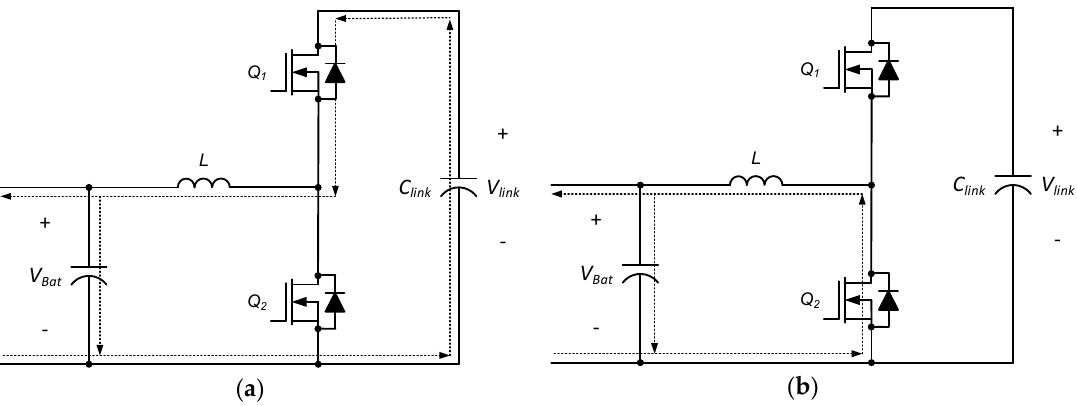
Figure 6. Capacitor discharge mode ( a ) Q 1 : turn on, Q 2 : turn off, ( b ) Q 1 : turn off and Q 2 : turn on.